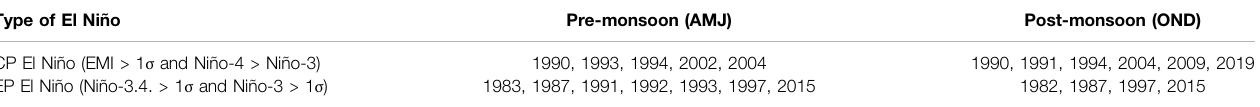
TABLE 1 | Identi fi ed EP El Niño and CP El Niño in AMJ and OND. Type of El